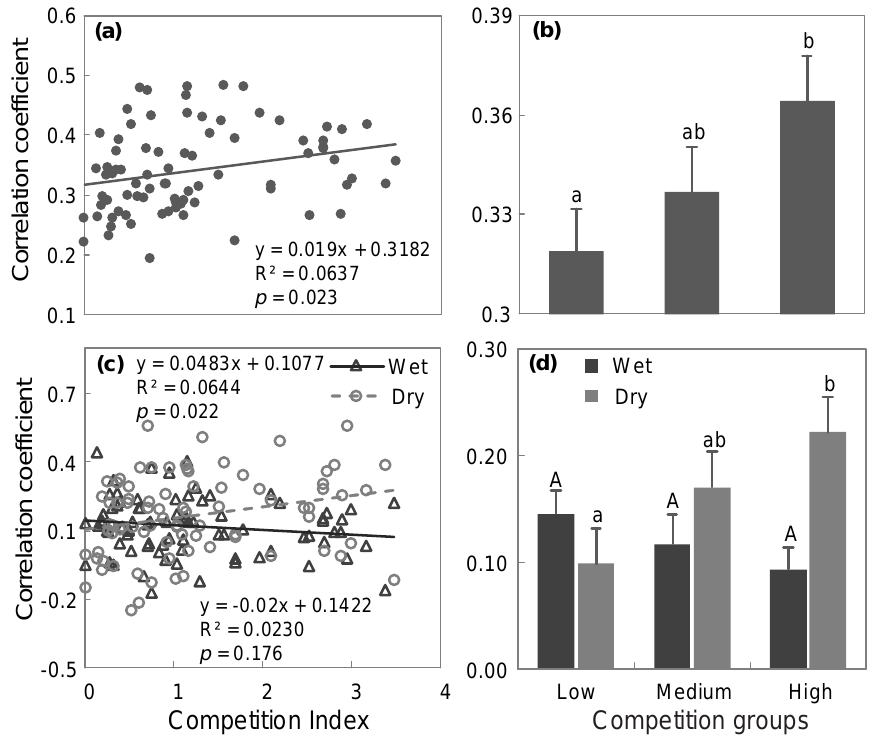
Figure 2. Linear regression ( n = 82) between CI and correlation coefficients ( r ) for all the trees ( a , c ) and average correlation coefficients between precipitation and the RWI for low (SE; n = 27), medium (SE; n = 28) and high (SE; n = 27) competition-level trees ( b , d ). Correlation coefficients were calculated for ( a , b ) all years (1955–2015), ( c , d ) 31 years with precipitation < average (dry years) and 30 years with precipitation > average (wet years). Different letters indicate significant differences ( p < 0.05) among tree competition groups.